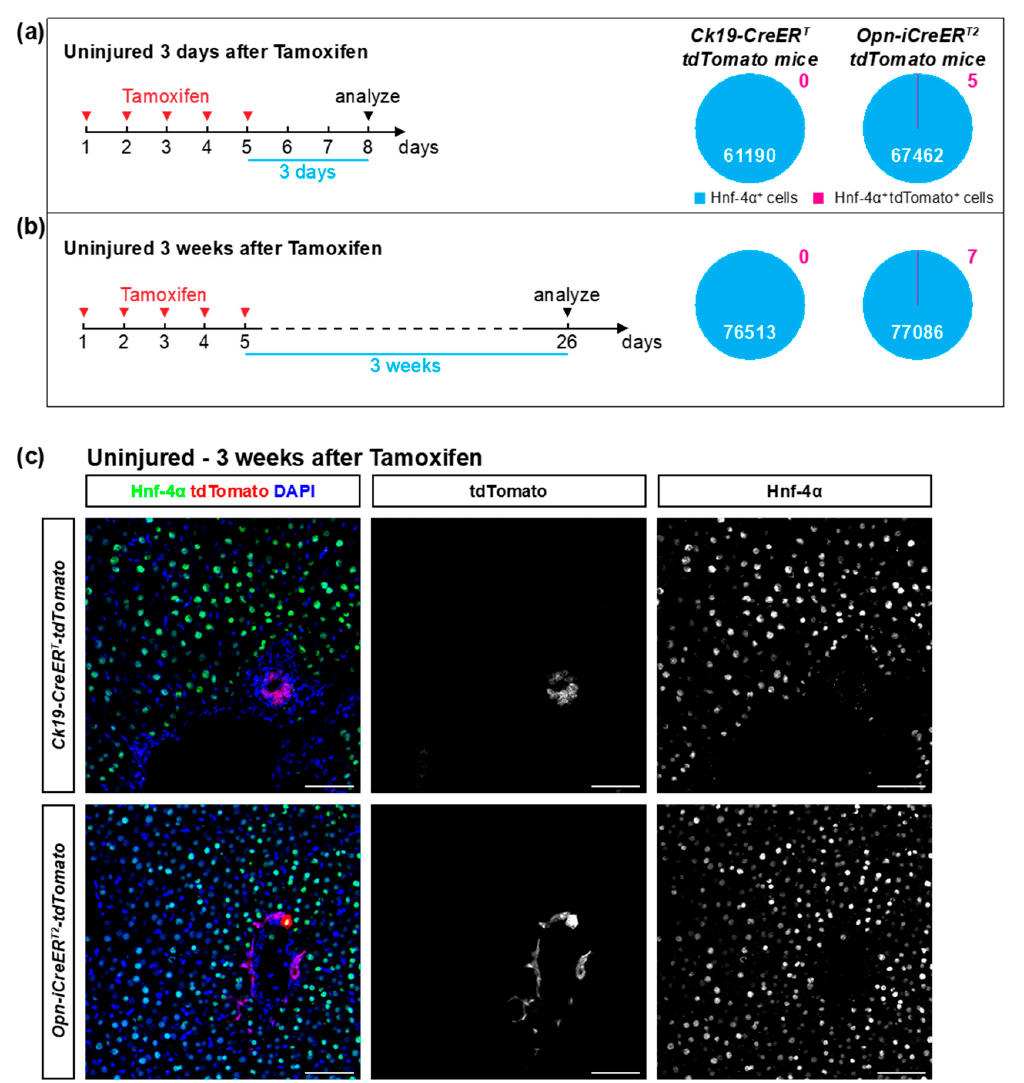
Figure 2. The Ck19-CreER T and Opn-iCreER T2 drivers are highly specific towards cholangiocytes in non-injured livers. ( a , b ) Schematic experimental outline. Mice were injected with tamoxifen and sacrificed three days or three weeks later. The percentage of tdTomato + Hnf-4 α + cells was quantified in liver sections of Ck19-CreER-tdTomato and Opn-CreER-tdTomato mice ( n = 7–8 mice per experiment; 18 pictures per mouse). No statistically significant di ff erences were detected between groups. ( c ) Immunofluorescent detection of Hnf-4 α and tdTomato in Ck19-CreER-tdTomato and Opn-CreER-tdTomato mice three weeks after tamoxifen. Scale bars: 50 µ